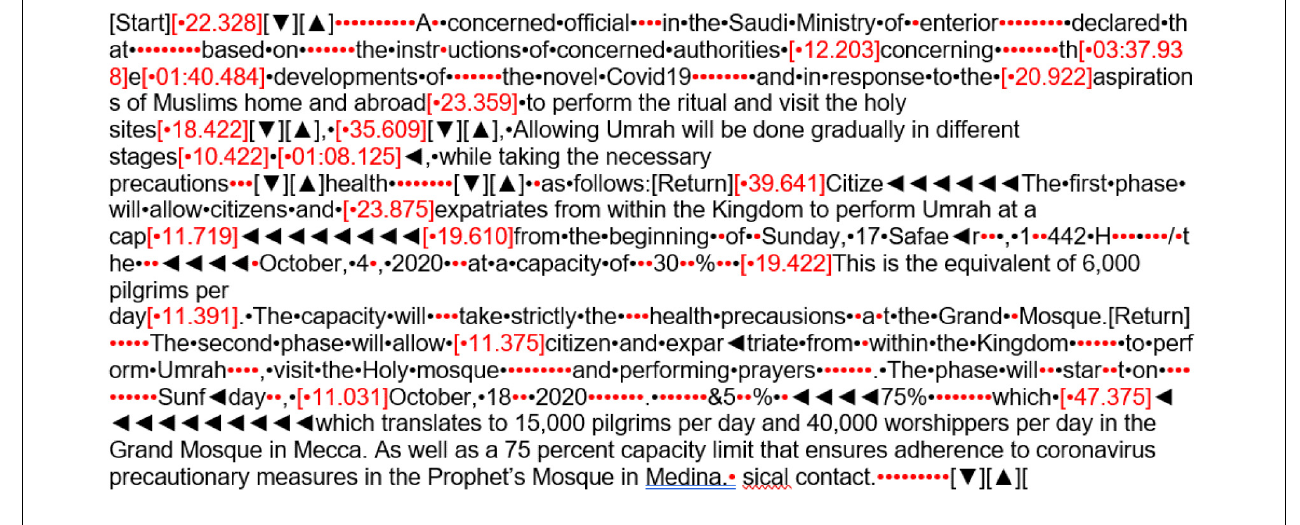
FIGURE 6 | Linear representation for project 2.